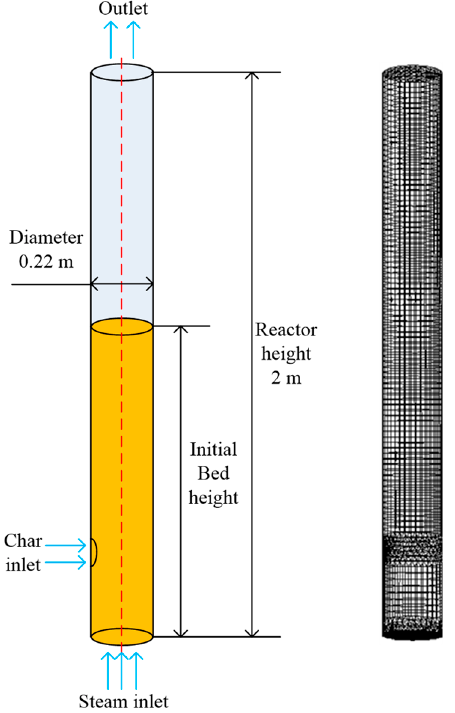
Figure 2. Geometry and mesh model of the BFB fuel reactor.